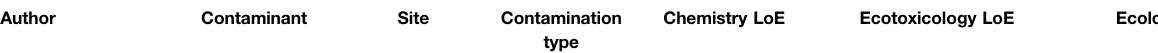
brackets represent the assigned tier of each